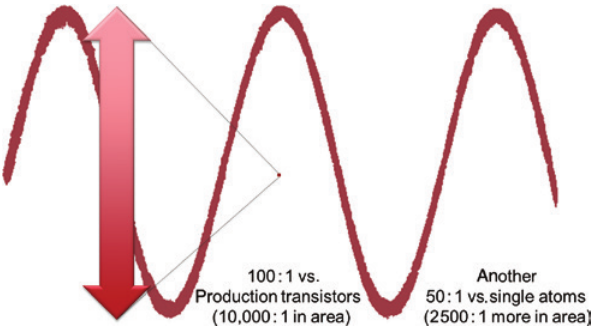
Figure 3: Device scale of optics vs. electronics.